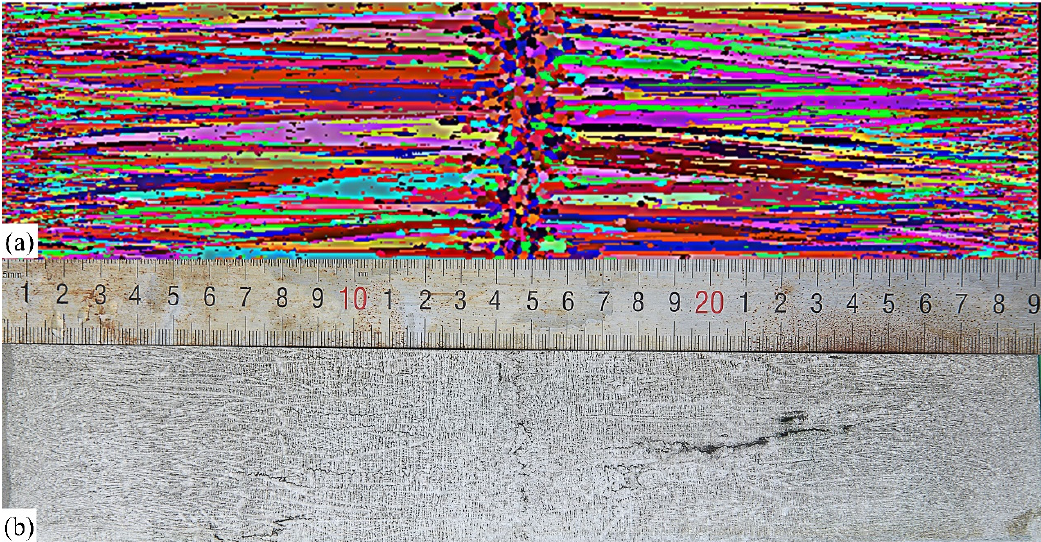
Figure 7. Comparison of the numerical and experimental structures of S-5 steel:( a ) simulated solidification structure ( b ) experimental solidification structure